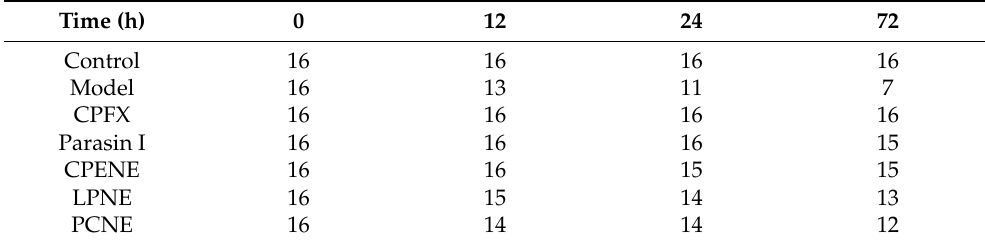
Table 2. The survival of mice in different groups at 0, 12, 24, 72